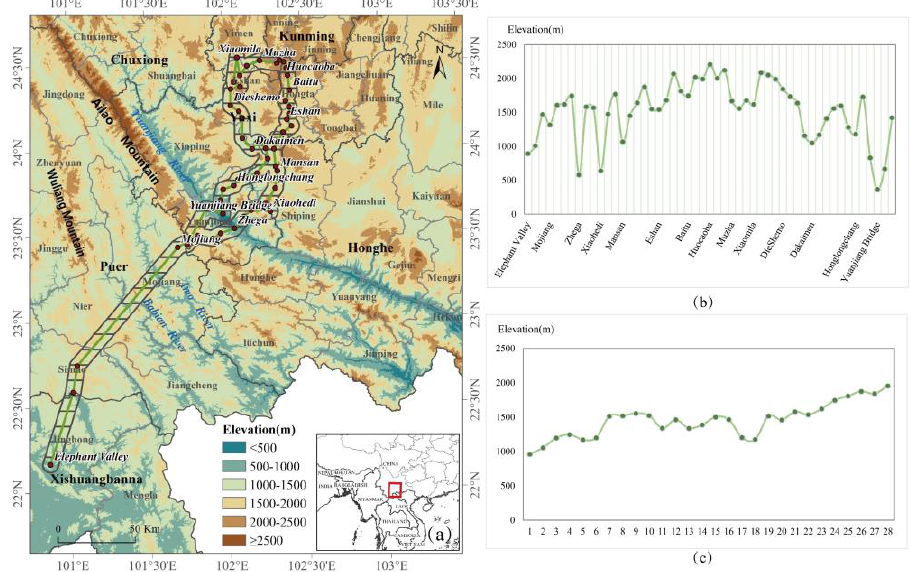
Figure 1. Elevation of the 2021 Asian elephant movement route. The figure was composed of three parts: ( a ) the spatial pattern of elevation, ( b ) the elevation change curve of recorded locations, and ( c ) the elevation change curve of the buffer grid from south to north.